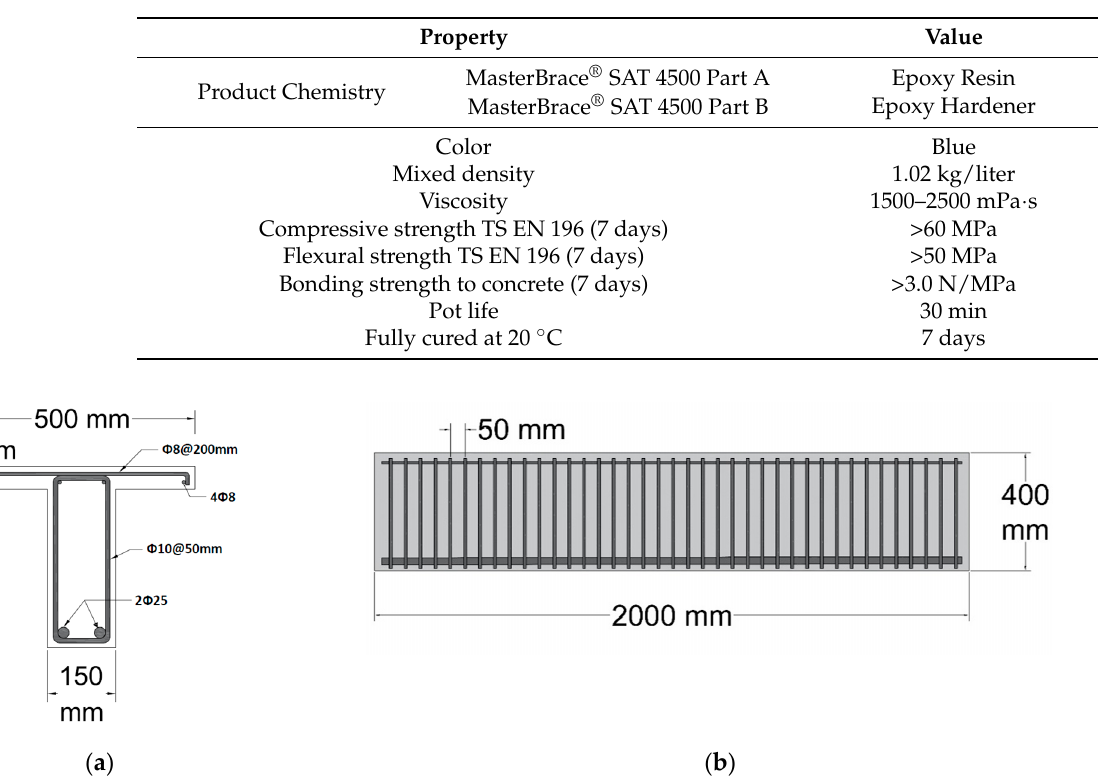
Table 6. MasterBrace SAT 4500 properties.